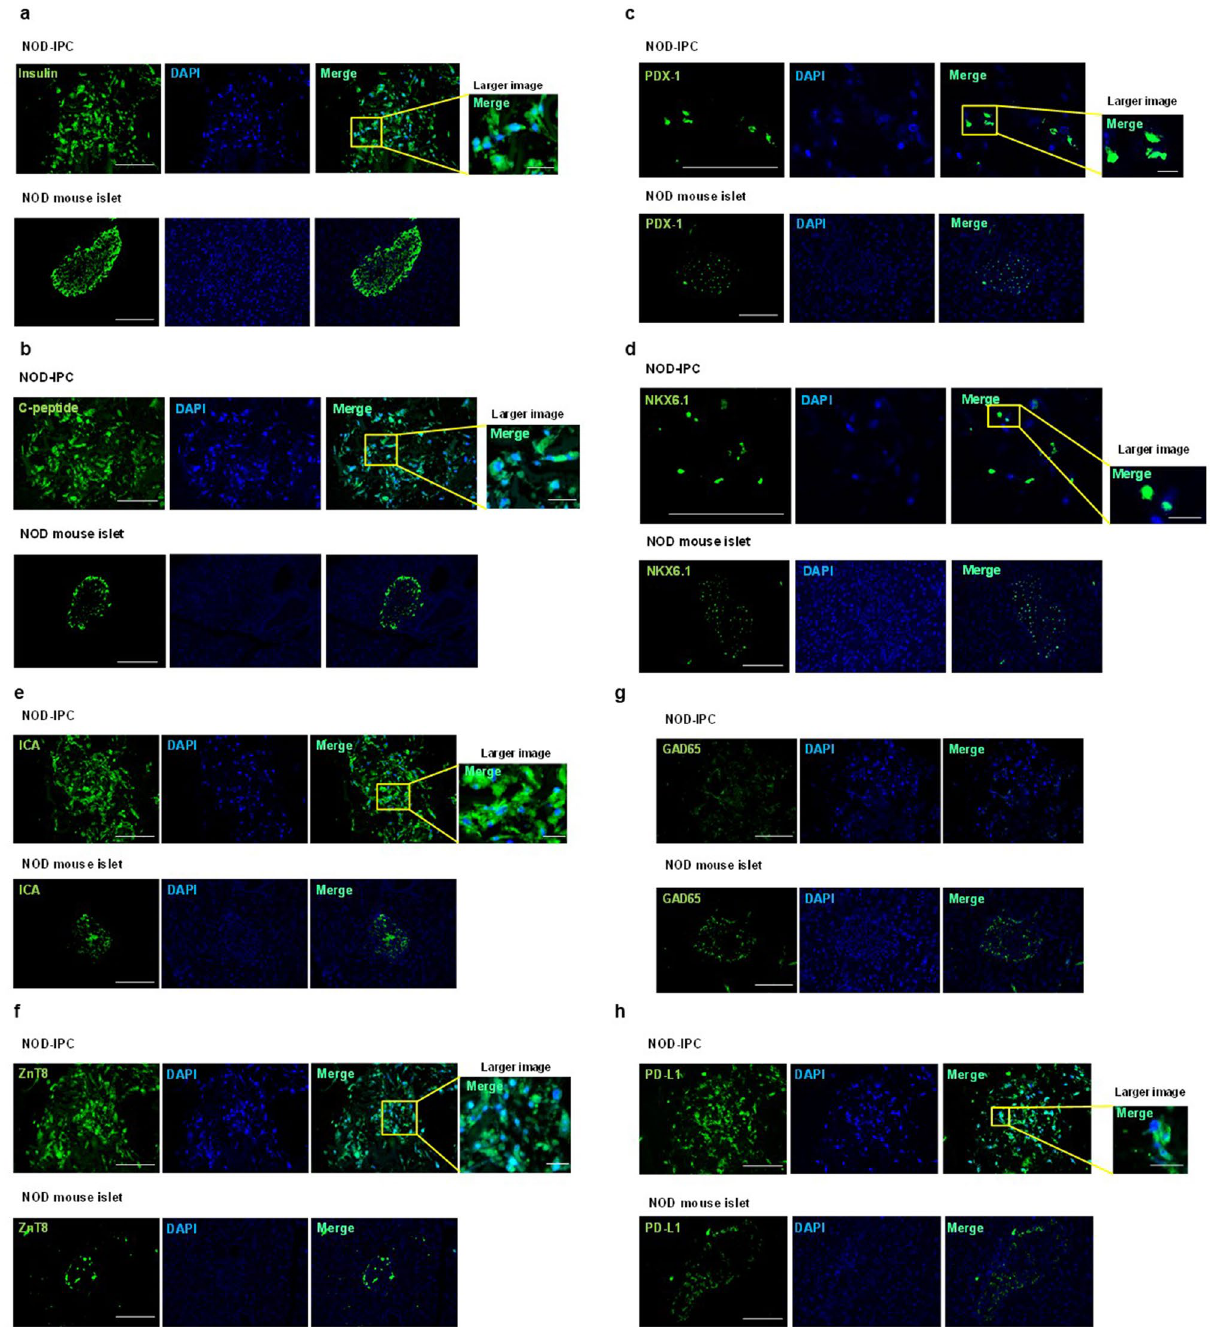
Figure 2. Morphology of the generated NOD-IPCs. ( a–d ) Immunofluorescence staining of insulin ( a ), C-peptide ( b ), PDX-1 ( c ), and NKX6.1 ( d ) in NOD-IPCs on day 28. Green: insulin, C-peptide, PDX-1, or NKX6.1; blue: DAPI. Scale bar, 200 μm; scale bar of the larger image, 25 μm. ( e–g ) Immunofluorescence staining of autoantigens (ICA, GAD65, and ZnT8) in NOD-IPCs on day 28. ICA and ZnT8 were highly expressed, whereas GAD65 was not expressed. Green: ICA, ZnT8, or GAD65; blue: DAPI. Scale bar, 200 μm; scale bar of the larger image, 25 μm. ( h ) Immunofluorescence staining of PD-L1, which was highly expressed in NOD-IPCs. Green: PD-L1; blue: DAPI. Scale bar, 200 μm; scale bar of the larger image, 25 μm. Islets of NOD mice were used as a